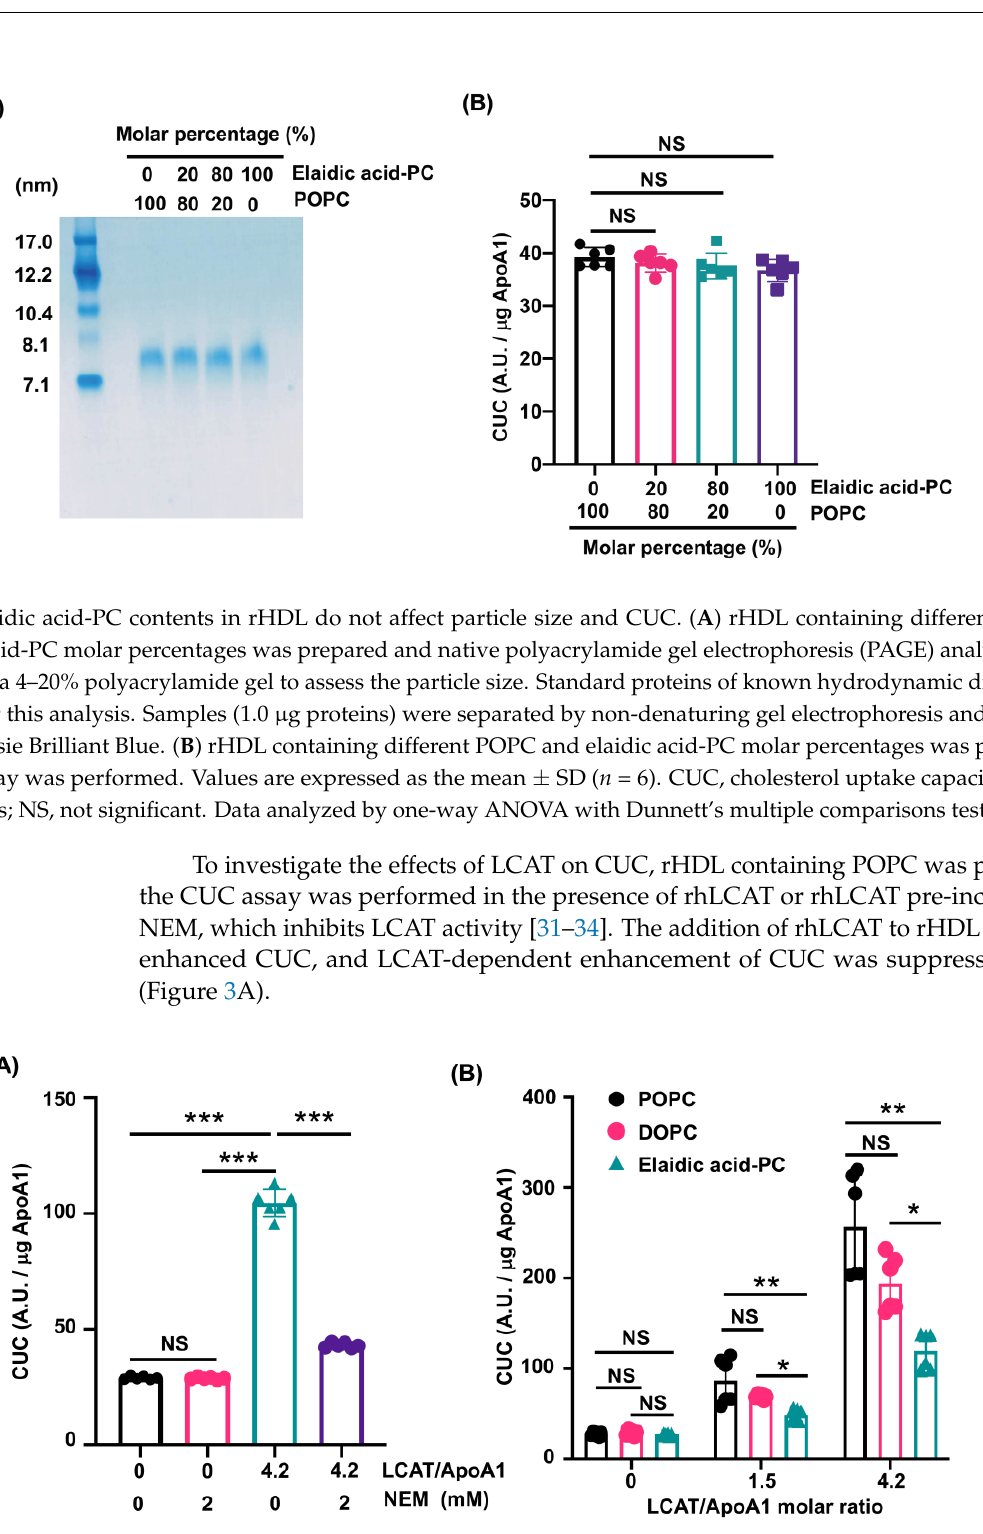
Figure 3. LCAT-dependent enhancement of CUC is suppressed in rHDL containing elaidic acid-PC. ( A ) rHDL containing POPC was prepared and a CUC assay was performed in the presence of rhLCAT or rhLCAT pre-incubated with NEM. Values are expressed as the mean ± SD ( n = 6). LCAT, lecithin cholesterol acyltransferase; apoA1, apolipoprotein A1; NEM, N-ethylmaleimide; CUC, cholesterol uptake capacity; A.U., arbitrary units. *** p < 0.001. NS, not significant. Data analyzed by one-way ANOVA with Tukey’s multiple comparisons test. ( B ) rHDL containing POPC, DOPC, and elaidic acid-PC was prepared and a CUC assay was performed in the presence of rhLCAT. Values are expressed as the mean ± SD ( n = 6). * p < 0.05, ** p < 0.01. NS, not significant. Data analyzed by one-way ANOVA with Dunnett’s multiple comparisons